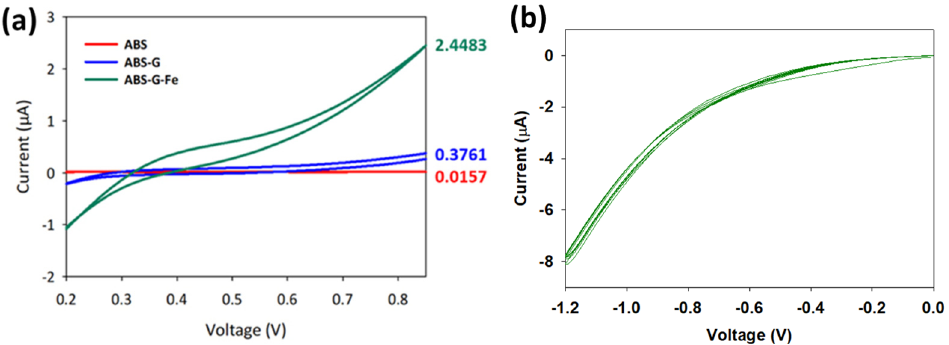
Figure 4. ( a ) CV curves of ABS, ABS-G, and ABS-G with electrodeposited ZVI; ( b ) electrodeposition of ZVI for five scan cycles using CV mode.